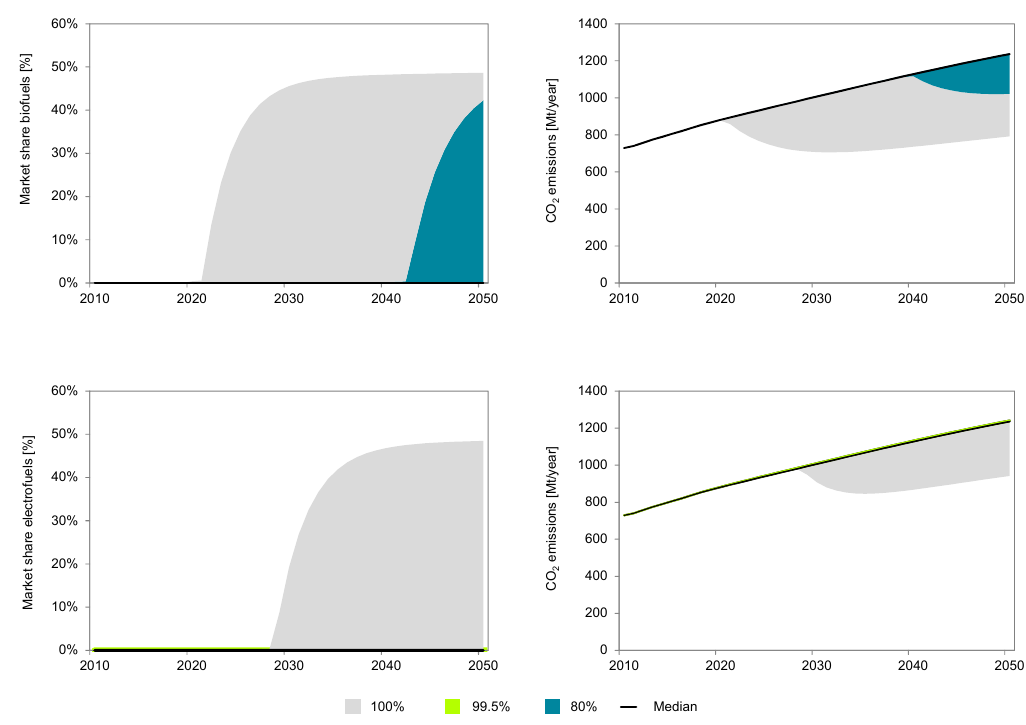
Figure 4. Results of the Monte Carlo simulation for biofuels ( top ) and electrofuels ( bottom ). Grey areas indicate 100%, green areas 99.5%, and blue areas the 80% of simulated values, which are closest to the median (black line).